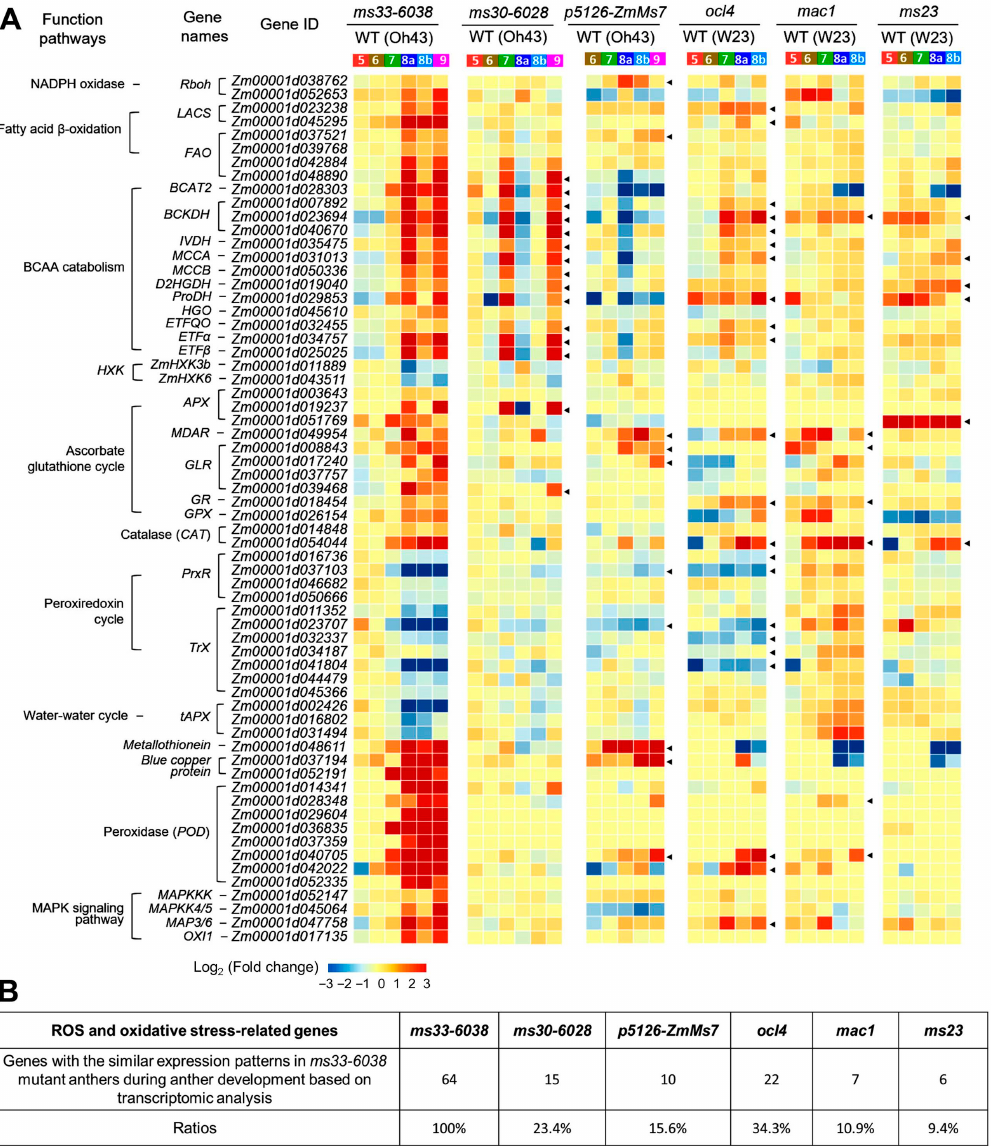
Figure 6. Transcriptome analysis of ROS and oxidative stress-related genes between ms33-6038 and each of the other five GMS lines. ( A ) The expression heatmap of ROS and oxidative stress-related genes in ms33-6038 and the other five GMS lines ( ms30-6028 , p5126-ZmMs7 , ocl4 , mac1 , and ms23 ). Arrow indicates a gene with a similar expression change to that in ms33-6038 anthers. ( B ) A summary of the numbers and percentages of ROS and oxidative stress-related genes with similar expression changes to ms33-6038 in each GMS line.